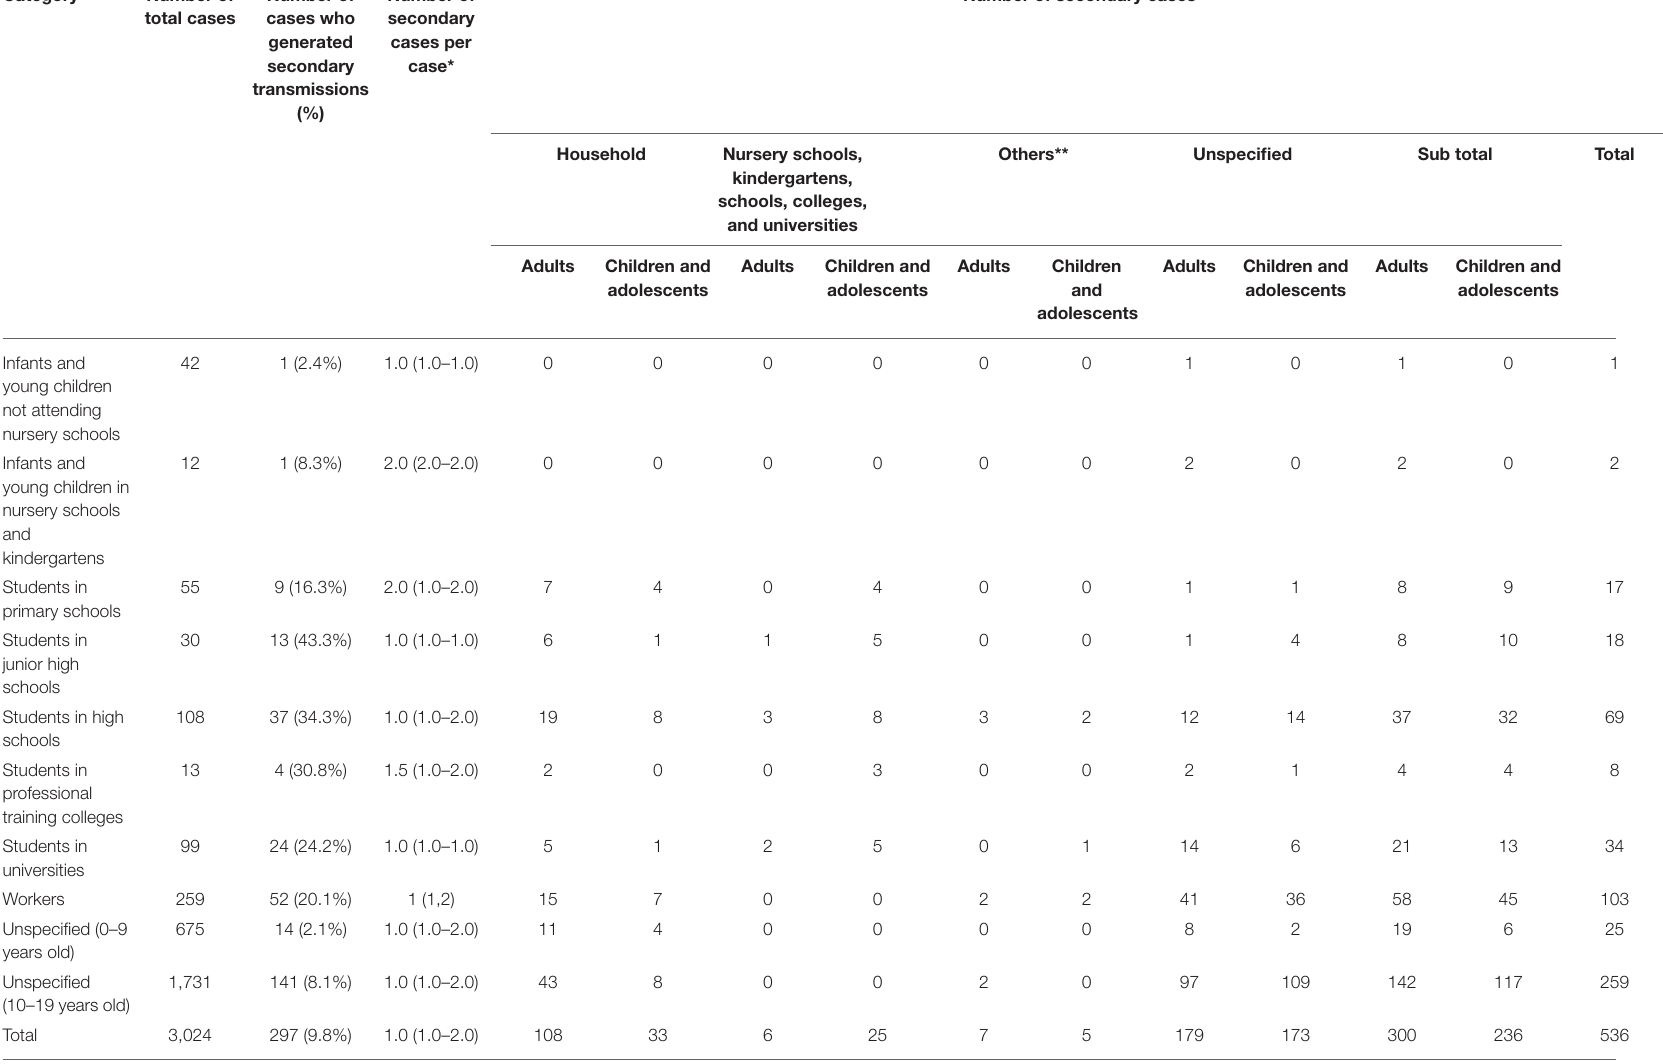
TABLE 2 | Secondary transmissions from COVID-19 cases of children and adolescents without known contact with previously confirmed cases.